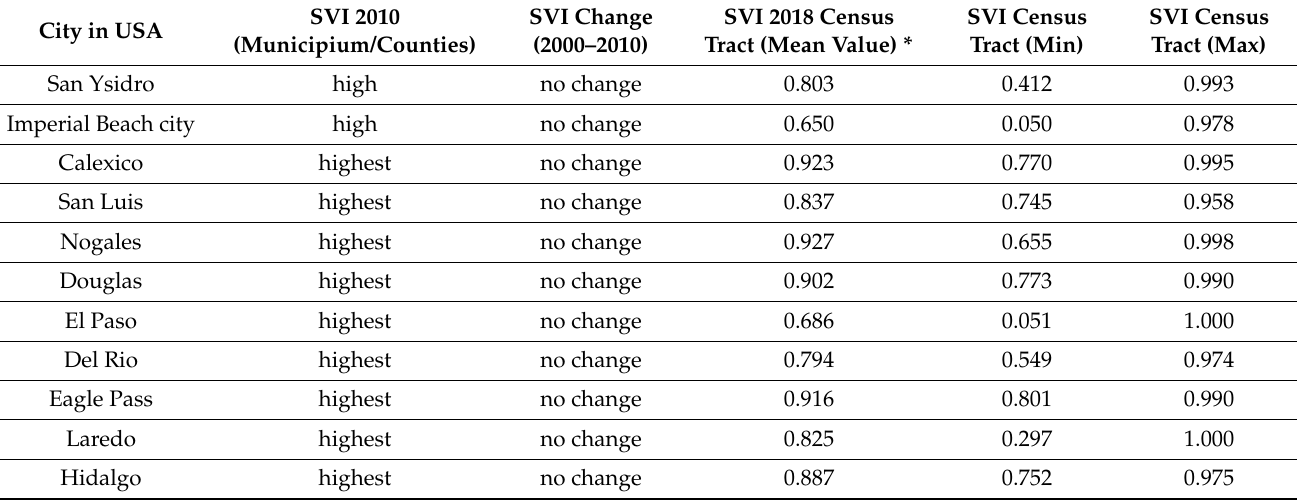
Table A3. SVI at census tract level in the